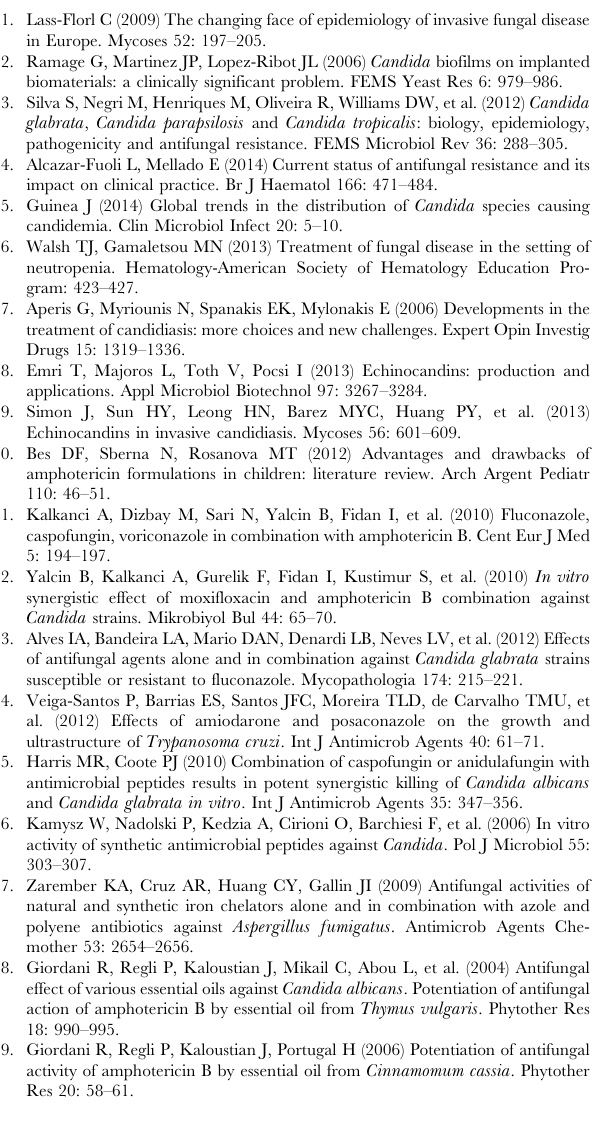
Figure S1 Growth of (A) C. tropicalis 519468 and (B) A. flavus at 34 u C in Mueller-Hinton broth (open squares) and RPMI (solid squares). (TIF) Figure S2 Effect of increasing concentrations of OligoG (0%, 2%, 6%, and 10%) on cell densities after cultivation in RPMI broth for 48 h at 34 u C for various Candida and Aspergillus species. Error bars represent standard deviation from the mean (n $ 4). (*, data not significantly different from control results; P . 0.05).